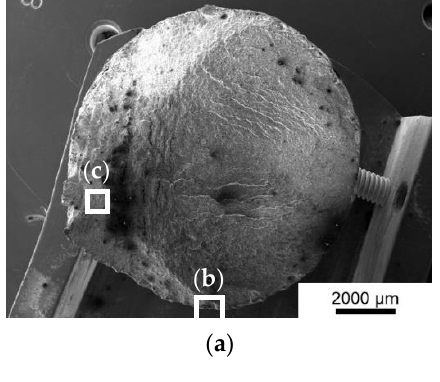
Figure 14. Fractography of machine hammer-peened (III) specimen loaded at 300 MPa and tested in 3.5% NaCl solution: ( a ) overview, ( b ) area of crack initiation with fatigue striations, ( c ) area of crack initiation with fatigue striations at higher magnification and ( d ) area of crack initiation with fatigue striations at higher magnification. Figure 15.